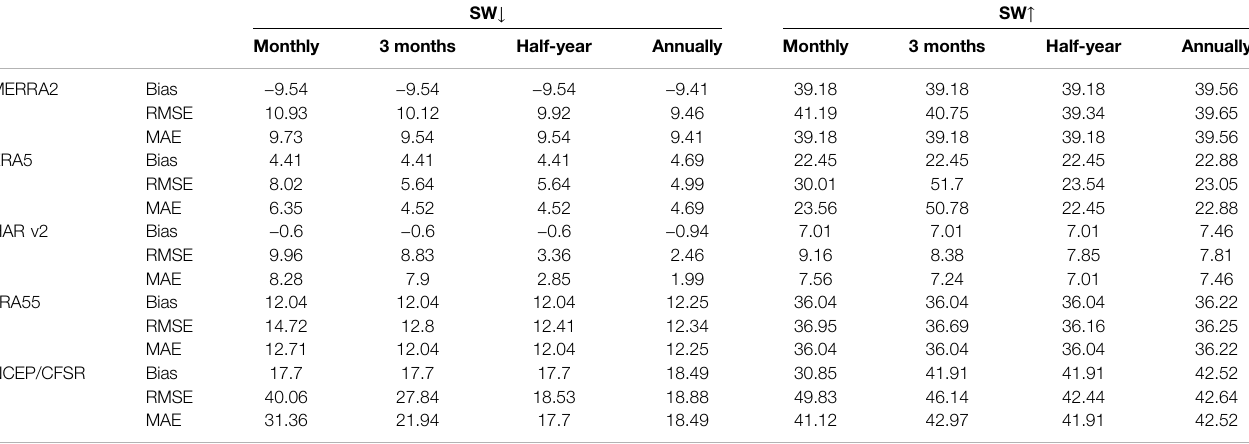
TABLE 7 | Evaluation of monthly and annual scales of longwave radiation from fi ve sets of reanalysis datasets.